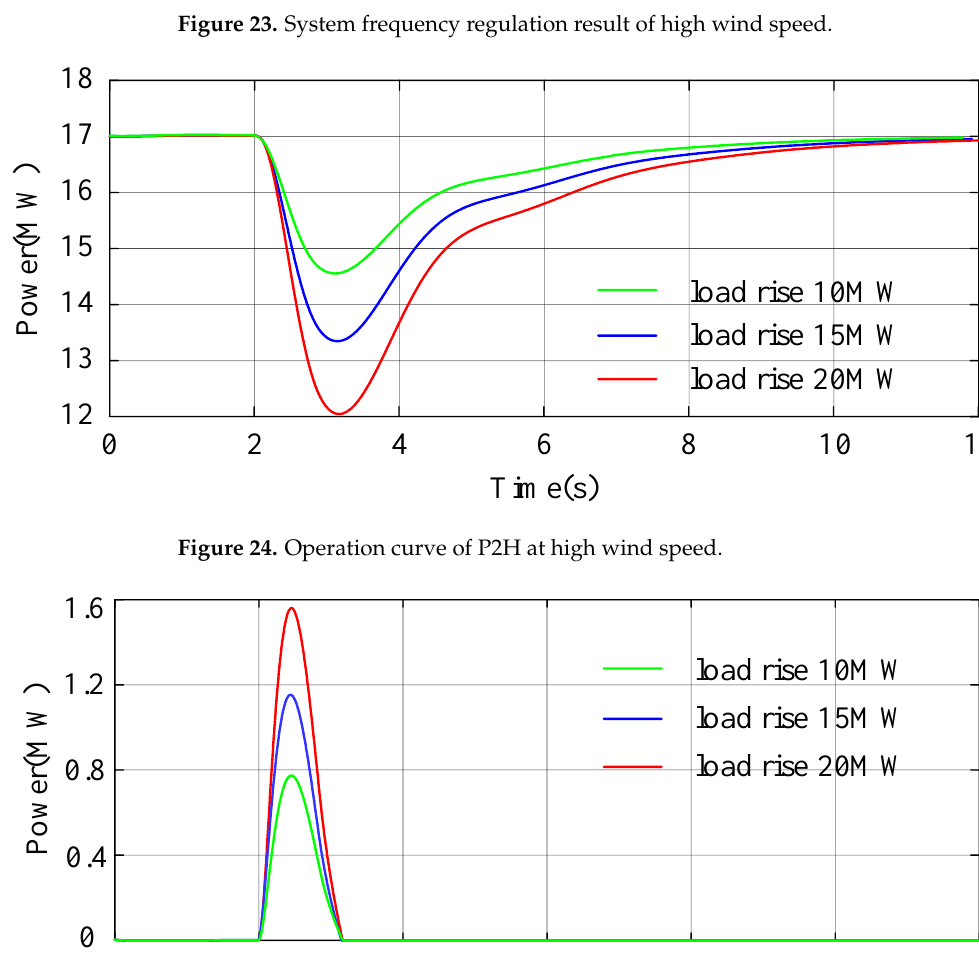
Figure 26. GSC and RSC running status curves of DFIG at high wind speed. As shown in Figures 23–25, the system frequency deviation caused by a load surge at the high wind speed was 0.21 Hz, 0.32 Hz and 0.41 Hz, respectively. When the wind speed was high, the wind turbine maintained the rated power output, a part of the